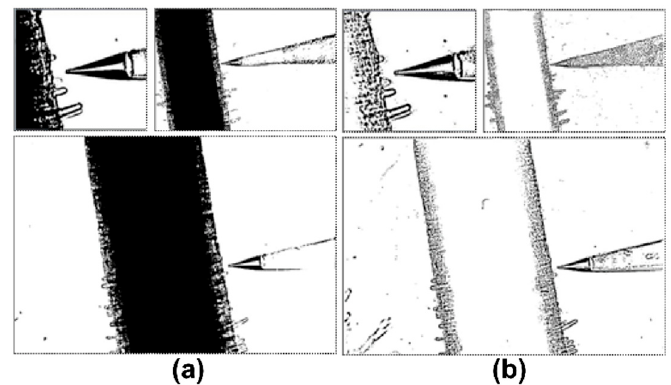
Figure 10. ( a ): The left three images are the results of global adaptive threshold selection binarization. ( b ): The right three images are the results of local adaptive threshold binarization.